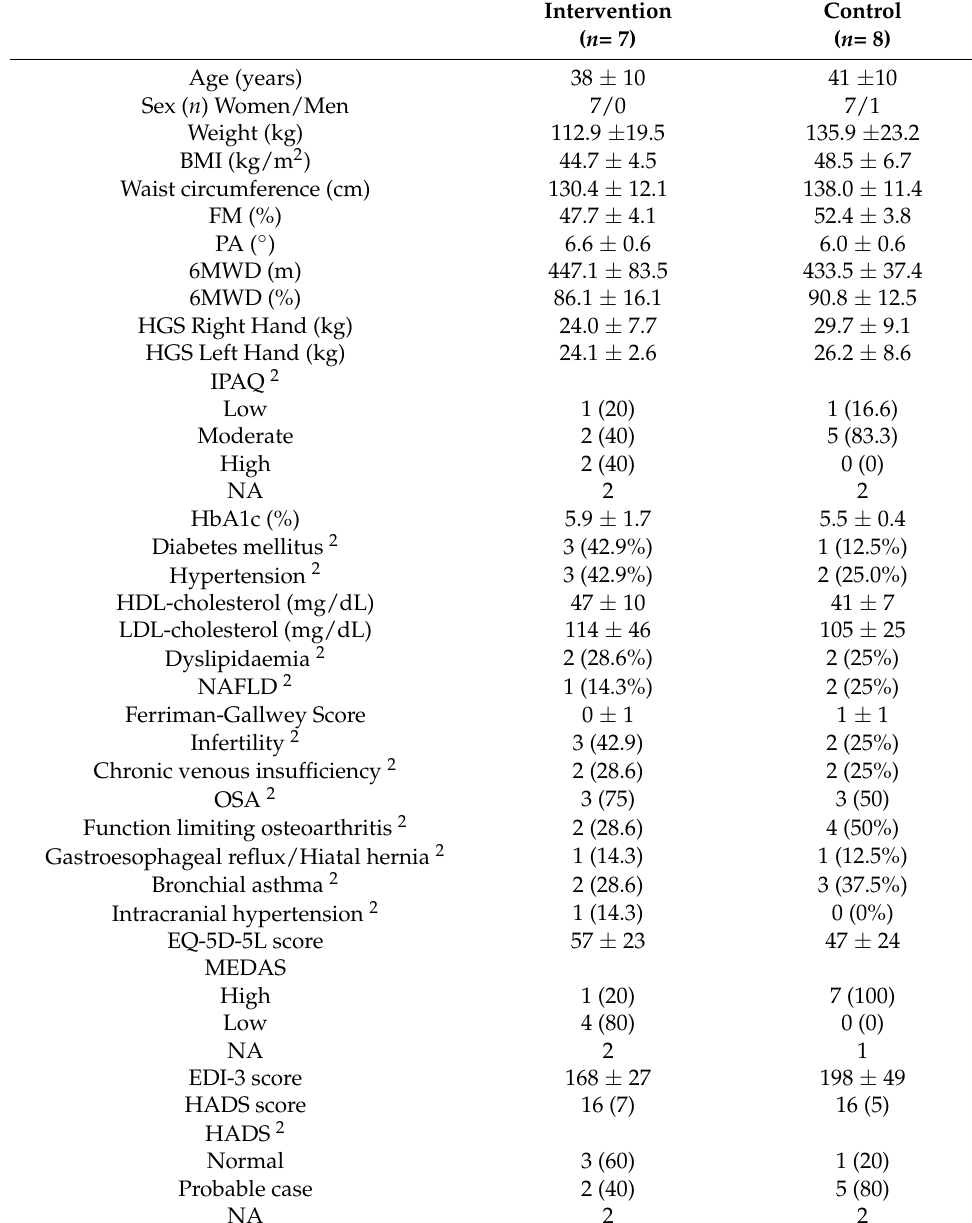
Table 2. Baseline characteristics of the pilot study population, according to the assigned treatment group 1